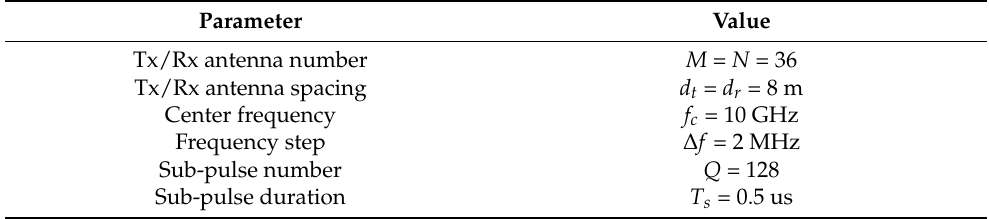
Table 2. 2D cross MIMO radar system